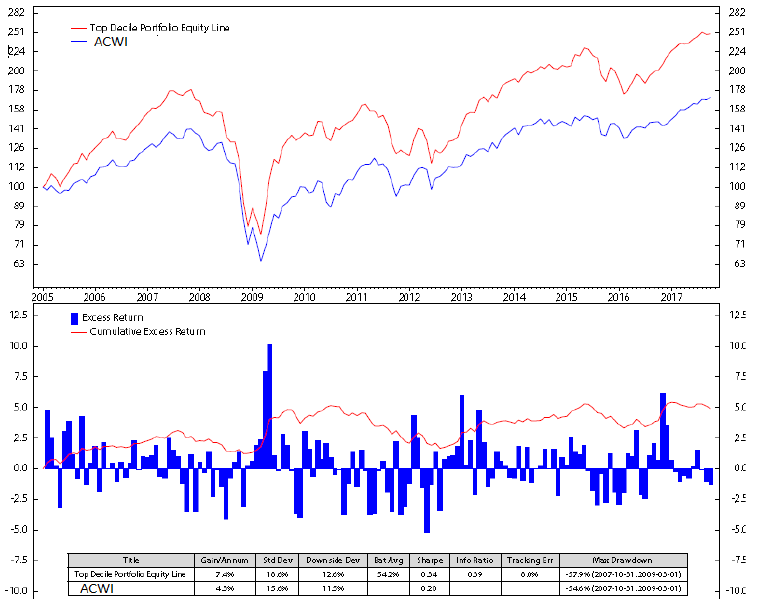
Figure 8. Global stock selection from January 2005 to September 2017 based on stock free cash flow/enterprise factor. The stock prices were scaled to $100.00 at the beginning of the stock selection process (January